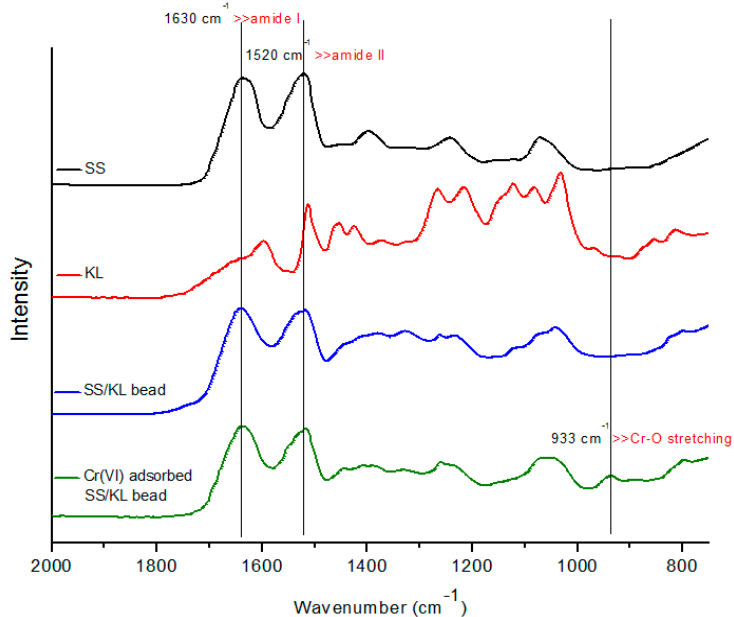
Figure 6. Fourier transform infrared (FTIR) spectra of raw SS, KL powder, SS/KL blend beads and Cr(VI) adsorbed on SS/KL blend beads.